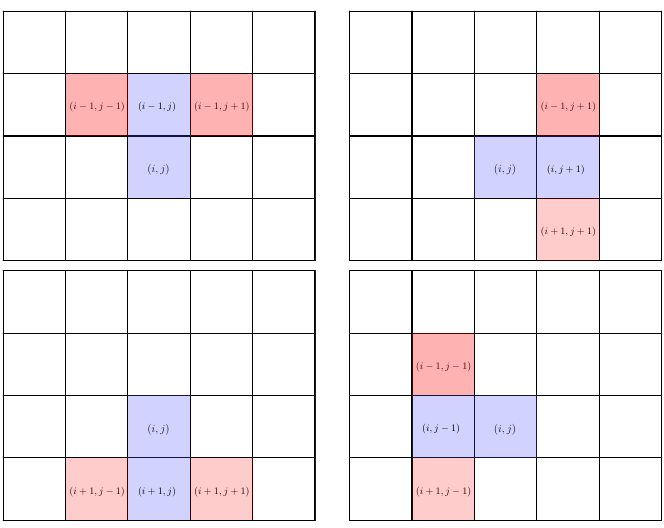
Figure 6. Construction of the set N 2 depending of the elements of N 1